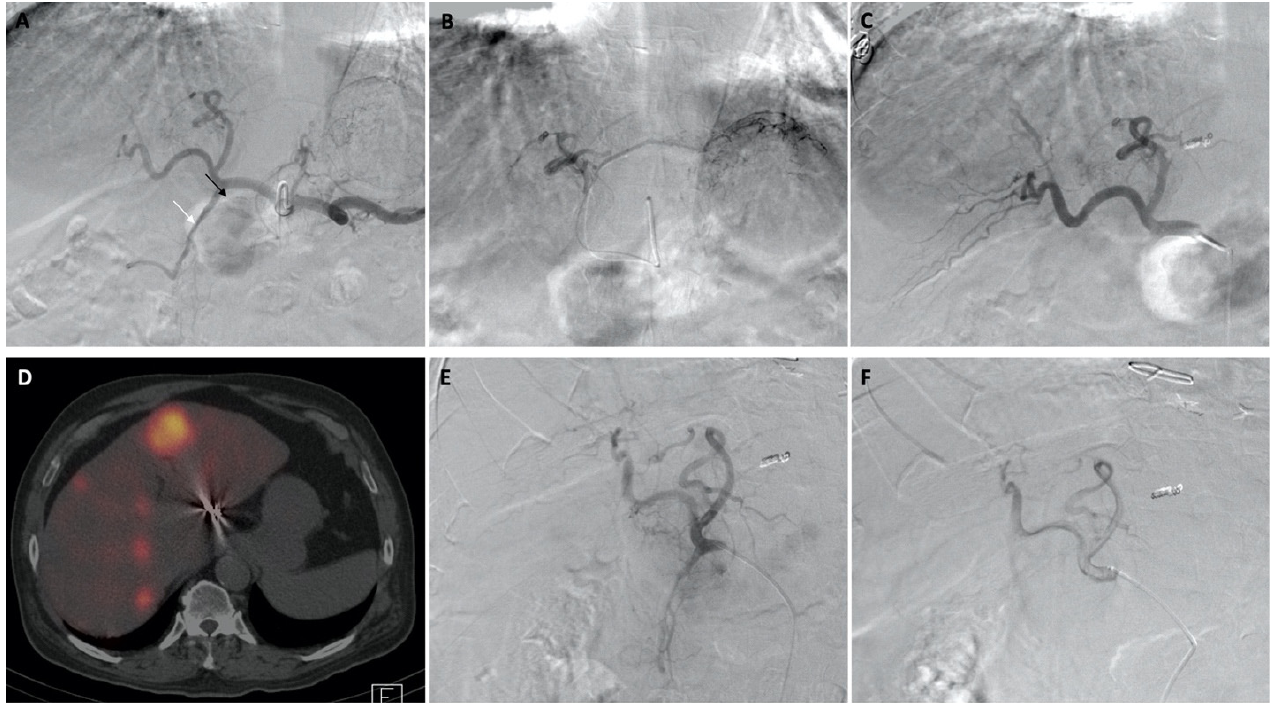
Figure 1. Images of a patient given diagnostic Tc-99m MAA injections and therapeutic 90 Y RE. Digital subtraction angiography through the celiac axis showed hepatofugal flow within the GDA (white arrow) and RGA (black arrow) ( A ). Further, selective left hepatic arteriography showed an accessory LGA ( B ), which was embolized. A repeat celiac arteriogram with the balloon occlusion technique showed flow reversal in the RGA and GDA ( C ). Nuclear scintigraphy using SPECT/CT after Tc-99m MAA administration showed adequate distribution of Tc-99m MAA within the liver without significant extrahepatic uptake ( D ). A repeat celiac arteriogram through the balloon catheter during 90 Y RE redemonstrated patency of the GDA and RGA ( E ) and flow reversal with inflation of the balloon ( F ).